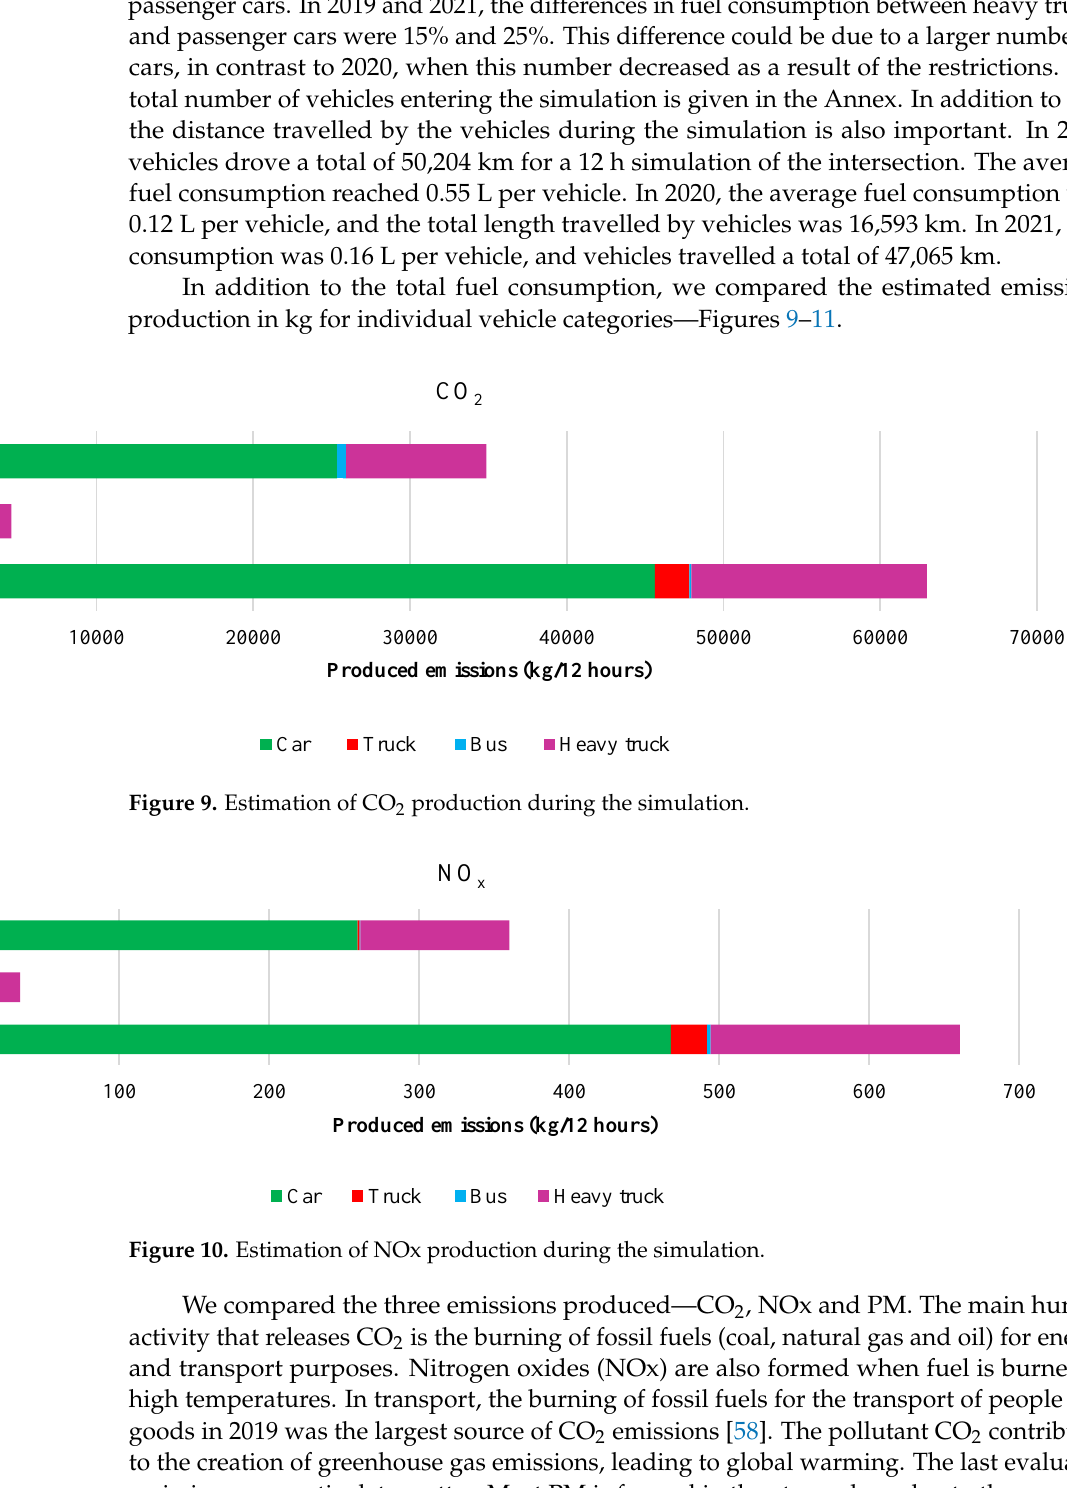
Figure 11. Estimation of PM production during the simulation.